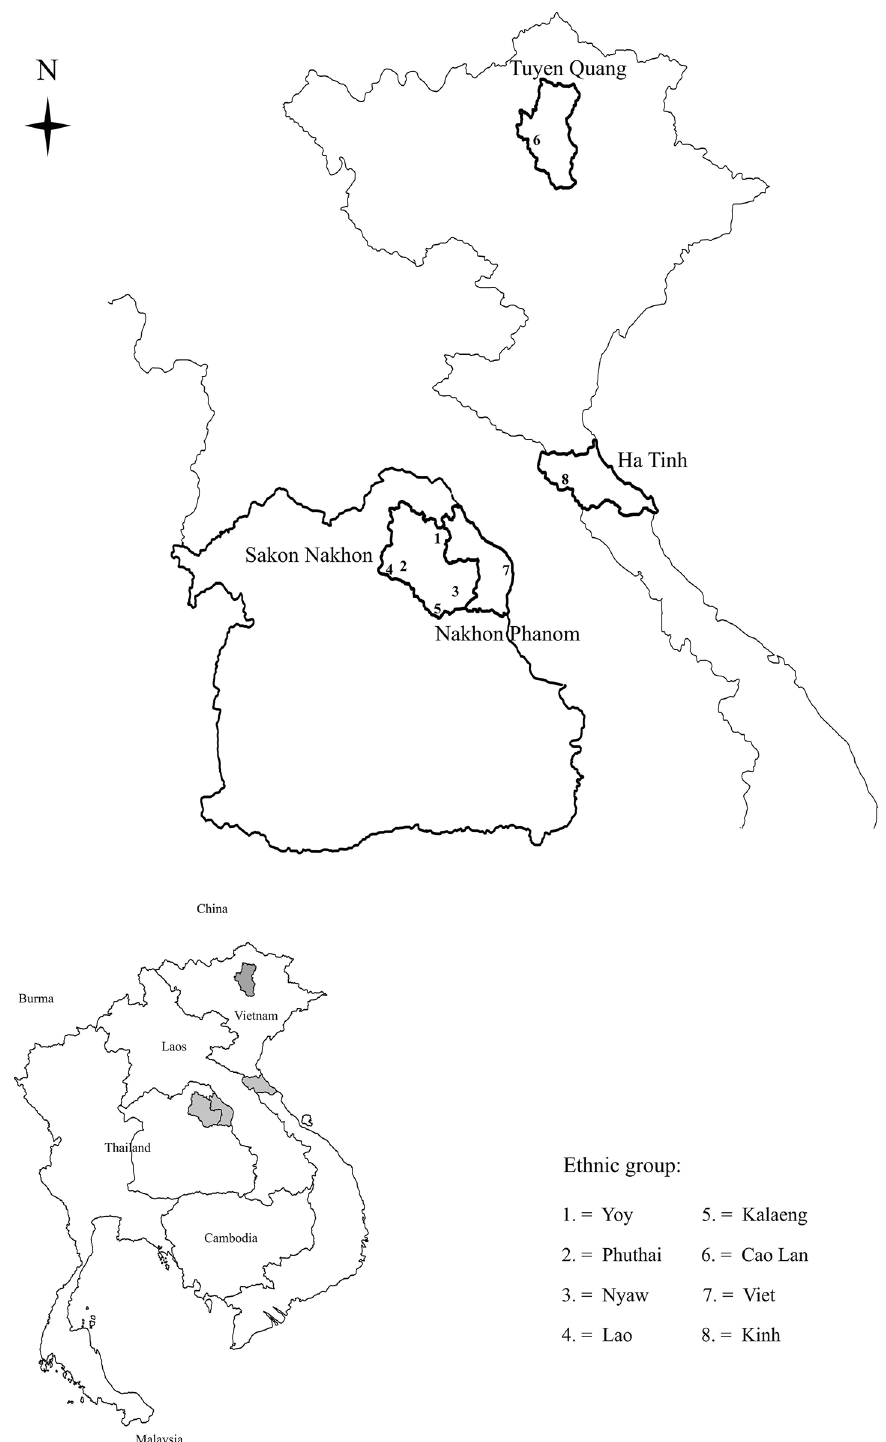
Fig 2. Map showing location of study villages in Northeast Thailand and Vietnam.